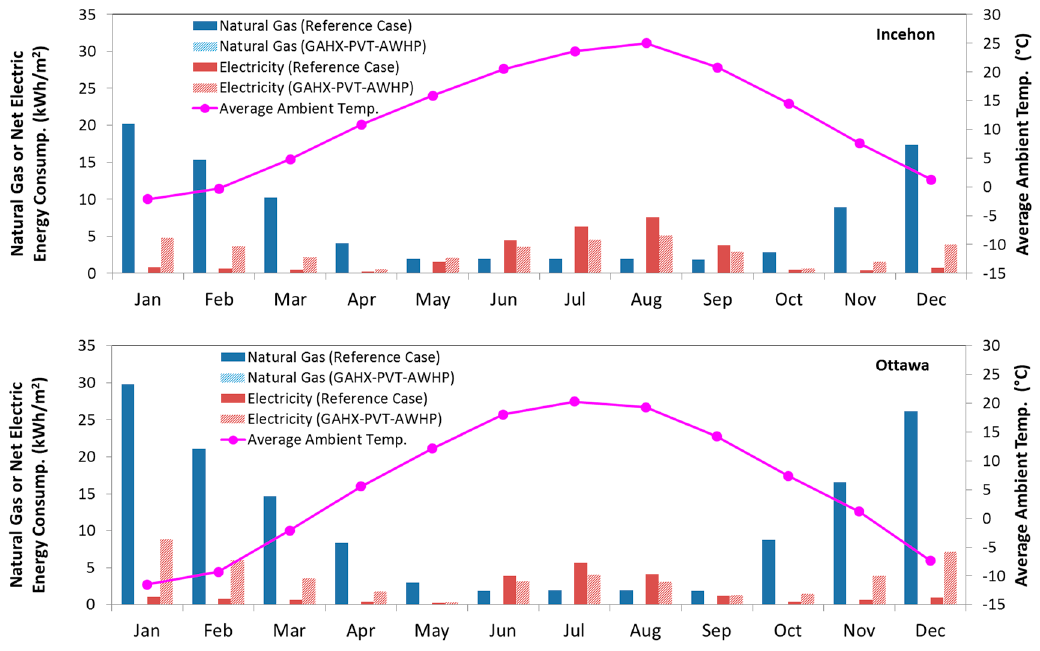
Figure 5. Monthly natural gas and net electrical energy consumption intensity.